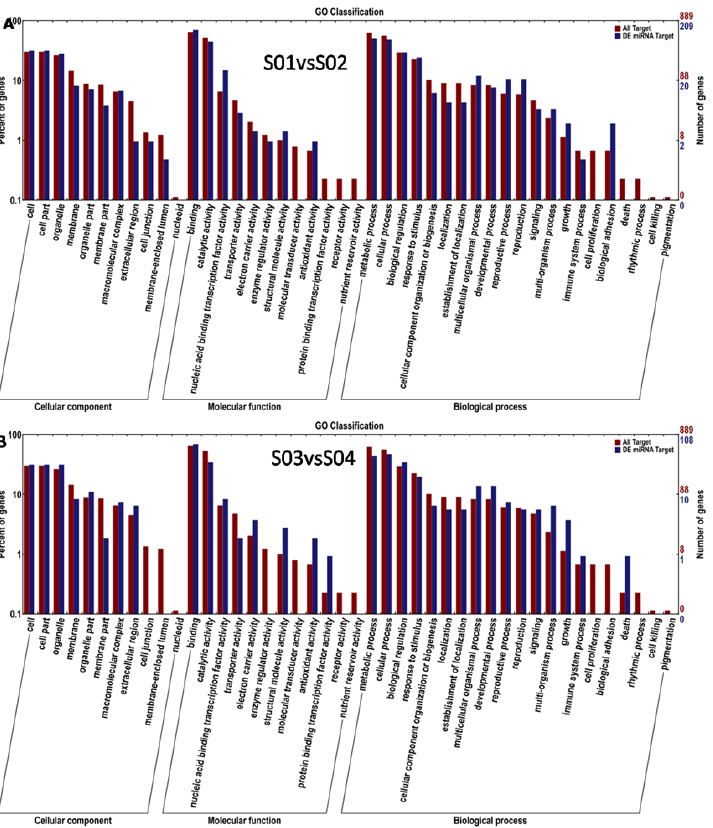
Figure 5. GO analysis of miRNA target genes identified in S01 vs. S02 ( A ) and S03 vs. S04 ( B ). The digits on the left y -axis and right y -axis indicate the percentage and enrichment of miRNA targets, respectively. Only the target genes identified for miRNAs by RNA sequencing were considered.